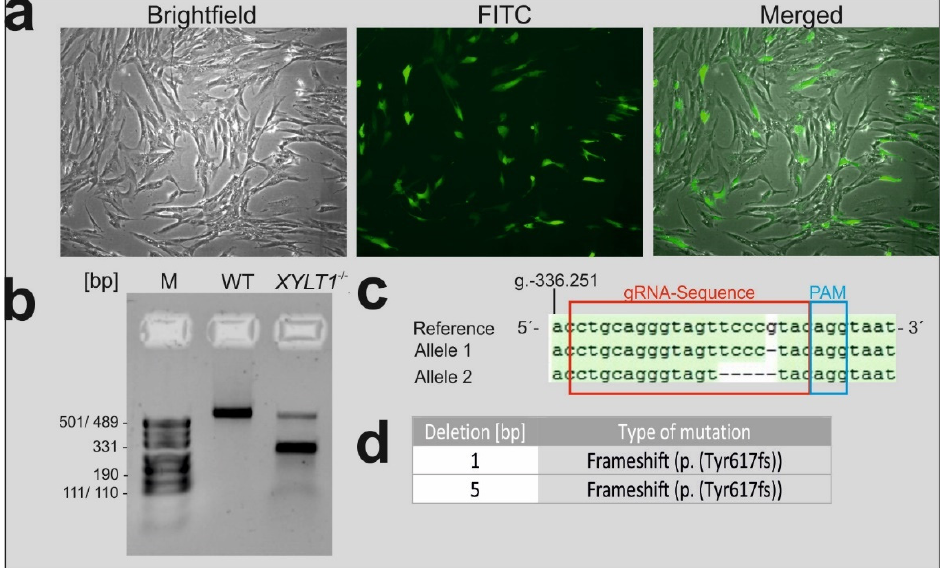
Figure 1. Transfection and subsequent characterization of CRISPR/Cas9-modified NHDF cells ( XYLT1 − / − ). Based on the GFP-expression, efficiency of pSpCas9(BB)-2A-GFP(PX458) all-in-one vector transfection was about 30% ( a ). By conducting a T7-endonuclease assay, a mutation rate of 80% was determined based on the intensity of the additional (non-wildtype) DNA-band ( b ). Allele-specific sequencing analysis of the DNA isolated from transfected cells revealed compound- heterozygous mutations characterized by deletions of 1 (Allele 1) and 5 (Allele 2) base-pairs (bp) within the genomic region complementary to the gRNA-sequence targeting exon 9 of the human XYLT1 gene (genebank accession ID: NG_015843.2). Resulting frameshift mutations (p. (Tyr617fs)) cause a premature stop-codon, leading to a truncated XT-I protein ( c , d ). M: marker; WT: wildtype.